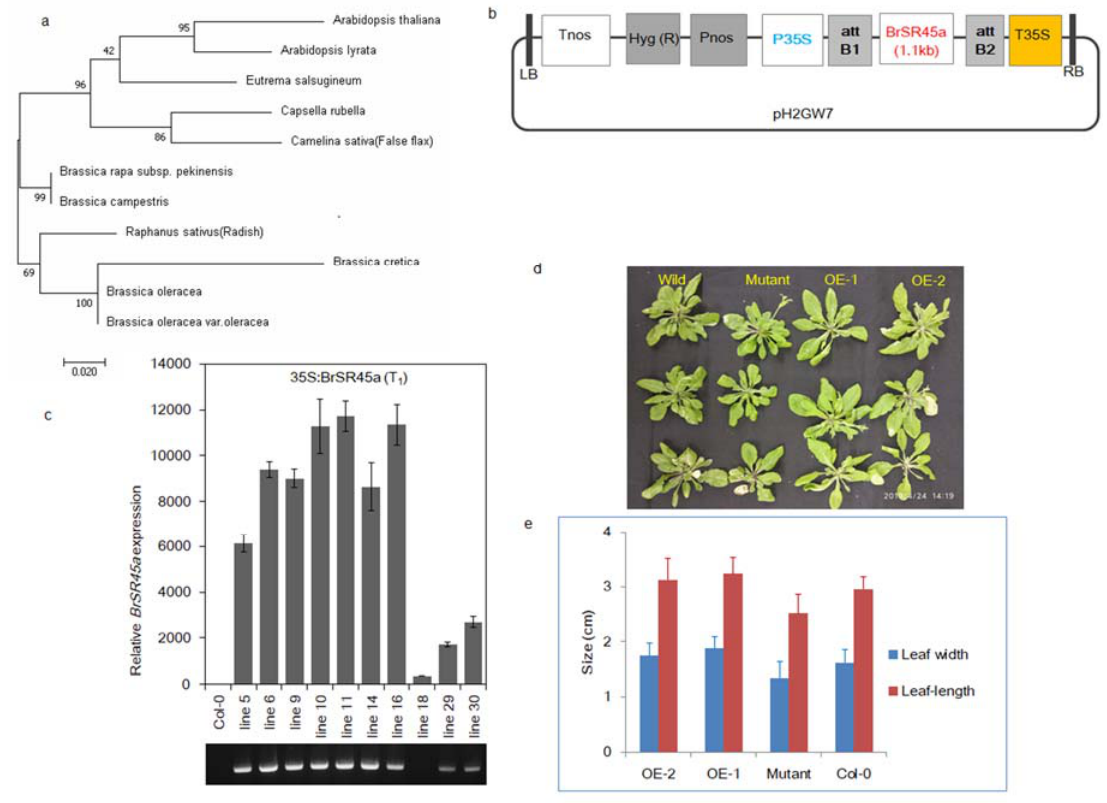
Figure 3. Heterologous expression of BrSR45a in Arabidopsis and its corresponding growth parameters. ( a – c ) denote the phylogenetic relationships, BrSR45a expression cassette, and expression level of BrSR45a in the transgenic Arabidopsis lines, respectively, while ( d , e ) compares the leaf growth parameters of BrSR45a overexpressors with that in SR45a knock-out mutants and control lines (Col ‐ 0).